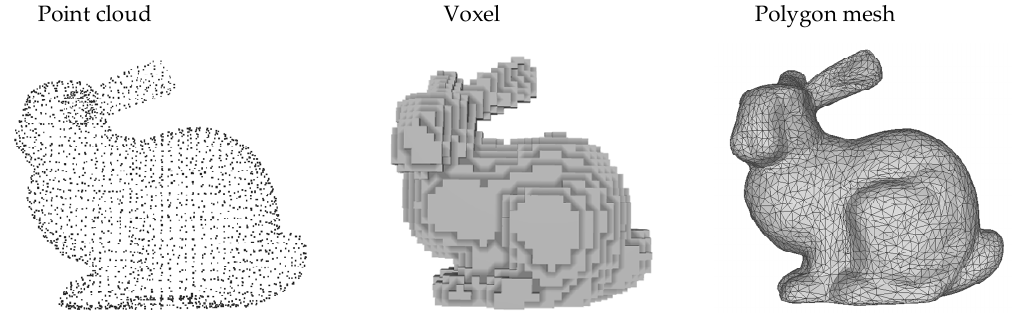
Figure 1. Point cloud, voxel, and polygon mesh representation of 3D models.